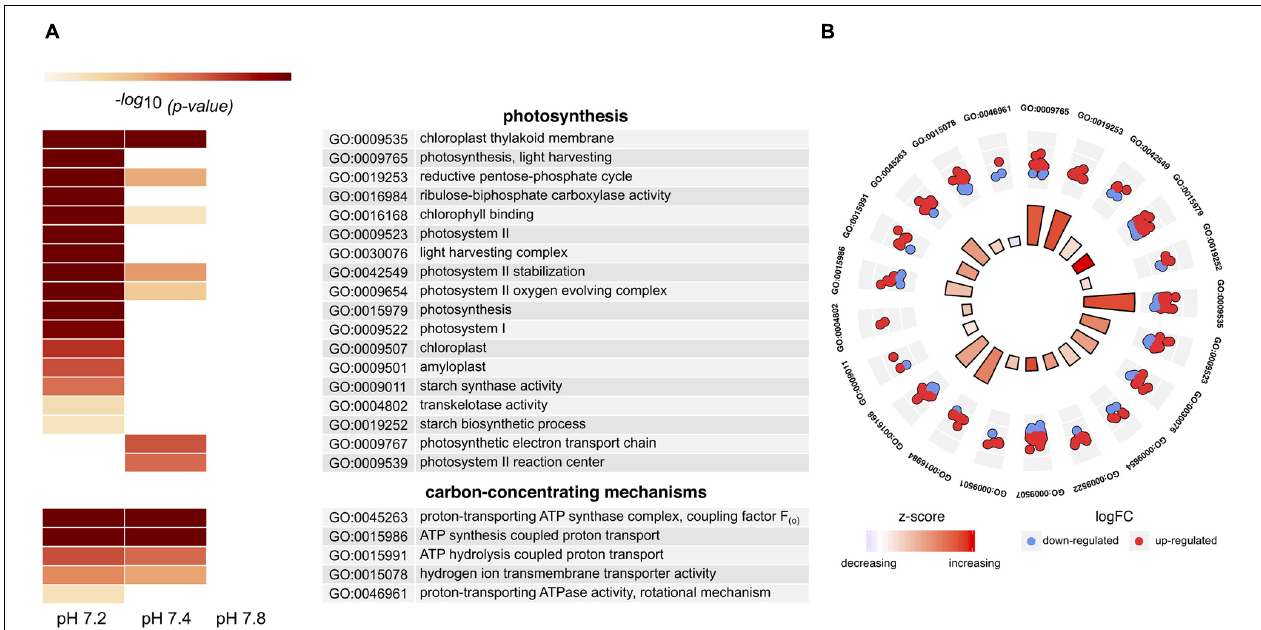
FIGURE 4 | Differential transcriptomic response of in hospite Symbiodinium microadriaticum CCMP2467 to CO 2 acidification stress. (A) Heat map showing GO terms related to photosynthesis and carbon concentrating mechanisms. Empty boxes denote differences that were not significant ( p ≥ 0.05). Annotation of each term is described in the table and p -values are provided in Supplementary Table 8 . (B) Circular plot showing selected GO terms enriched in pH 7.2. Statistical significance (log 10 adjusted p -value) of each GO term is shown by the height of the bars in the inner circle, while the color represents the overall regulation effect of each process as indicated by the z-score (red – increased, white – unchanged, blue – decreased). The outer circle scatterplots show the differentially expressed genes assigned to each process, where red and blue represent genes that are up- and down-regulation,